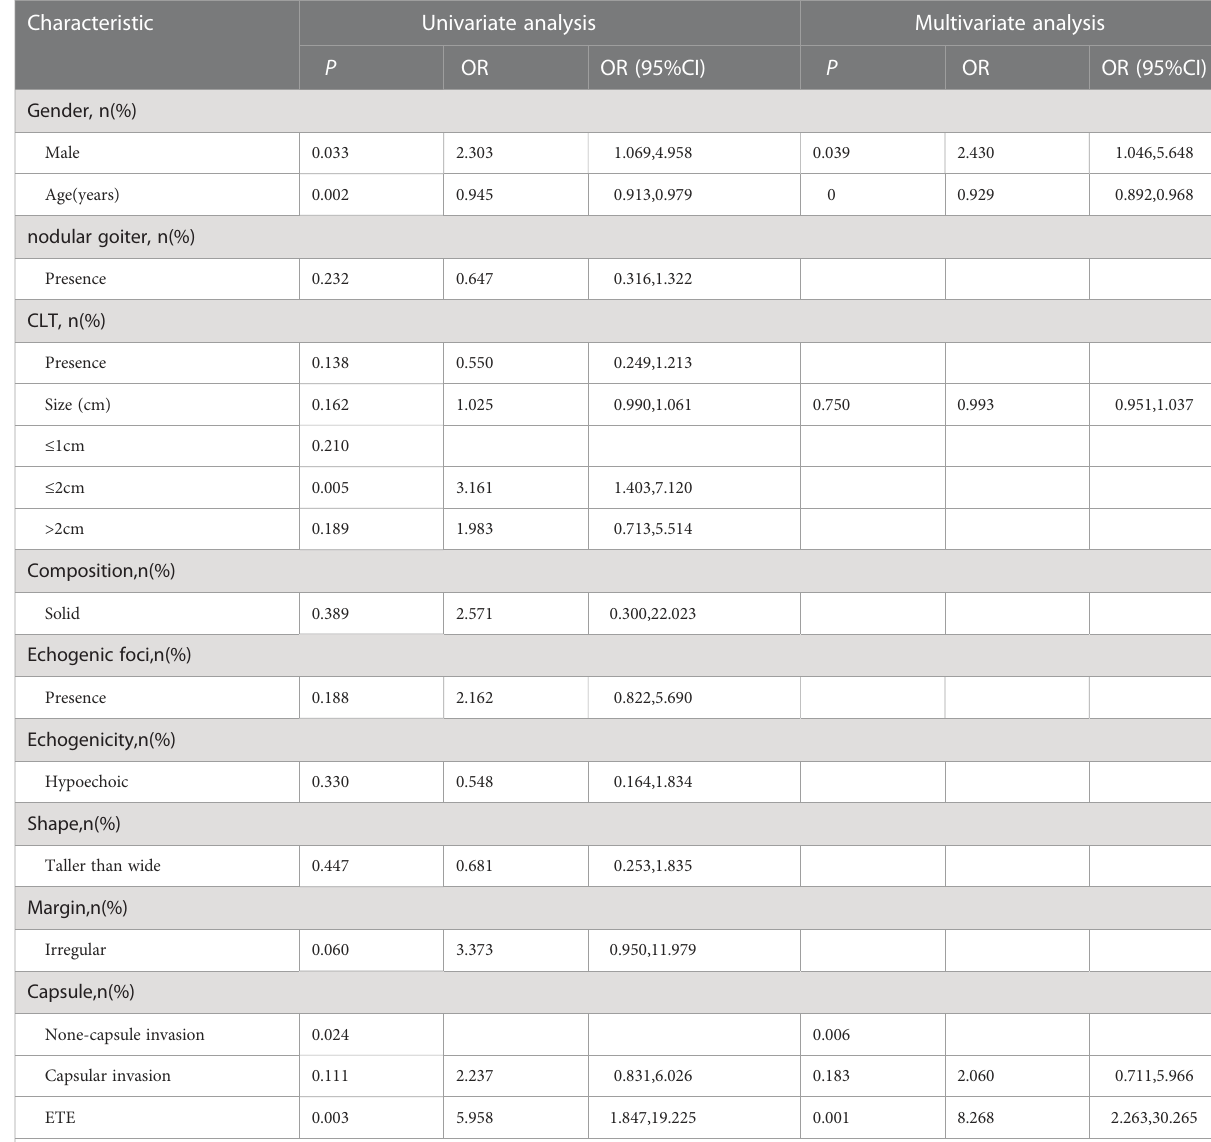
TABLE 4 Univariate analysis and multivariate analysis of factors associated with contralateral central lymph node metastasis (CLNM) in patients with isthmus papillary thyroid carcinoma (PTC).